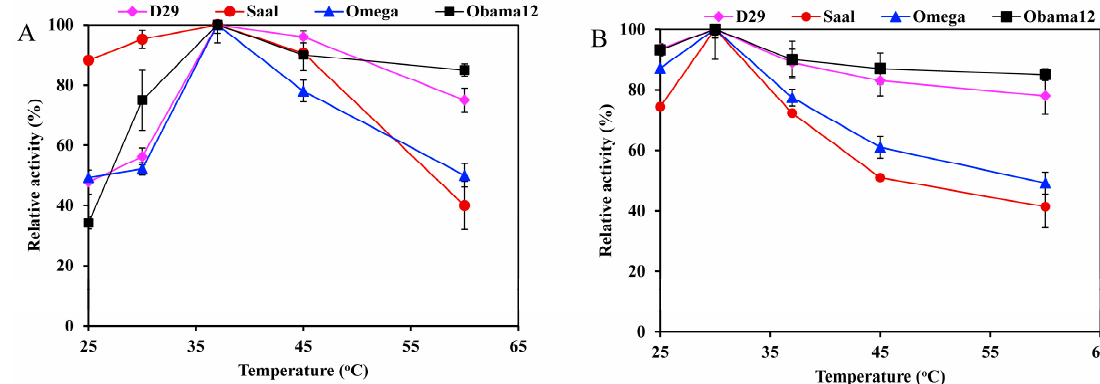
Figure 3. Temperature activity profiles of LysB-His 6 enzymes against: ( A ) 1 mM p NPB, and ( B ) 0.33% Tween 80. The lipase activity assay was performed in a temperature range of 25–60 ° C. Symbols: LysB-D29 ( ♦ ), LysB-Saal ( ● ), LysB-Omega ( ▲ ) and LysB-Obama12 ( ■ ). The 100% activity corresponded to 10, 9.77, 0.0524 and 0.015 U/mg in case of p NPB, and 42.1, 1.058, 7.11, and 4.49 kU/mg in case of Tween 80 for LysB-D29, -Omega, -Saal, and -Obama12, respectively. The experimental details are